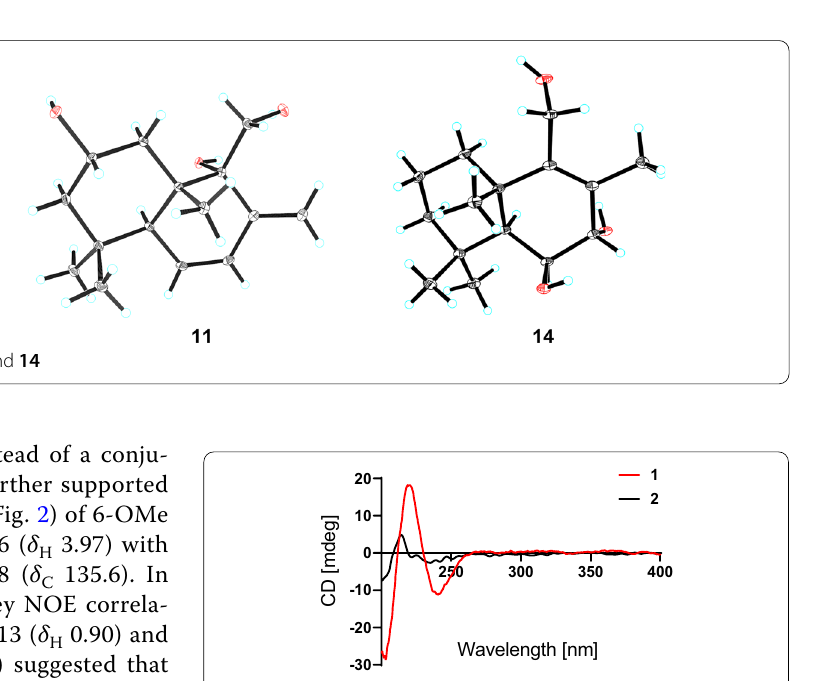
Fig. 5 Experimental ECD curves of compounds 1 and 2 in